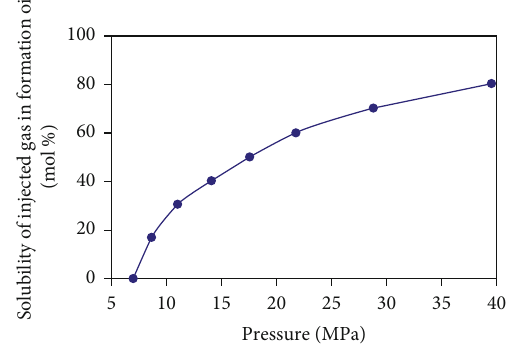
Figure 2: Curve of pressure versus CO